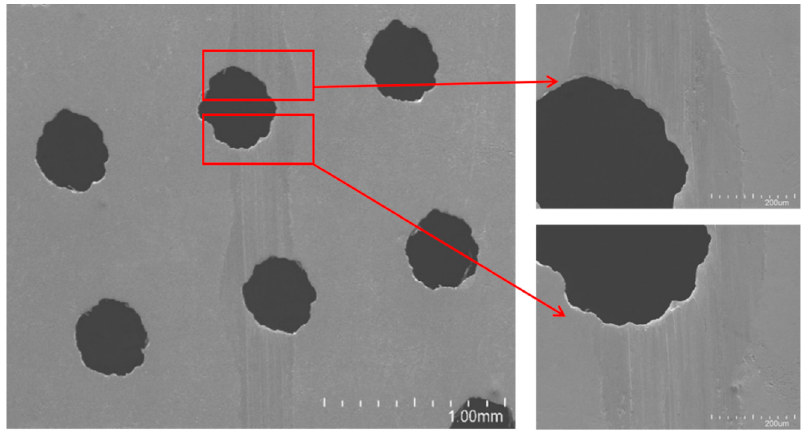
Figure 12. SEM images of wear track under the load of 5 N and the sliding speed of 0.5 Hz.